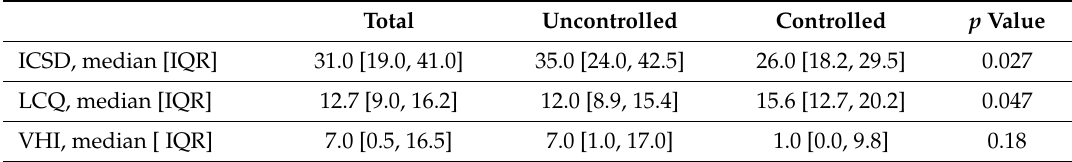
Table 2. Upper airway symptoms in Uncontrolled and Controlled study participants (n =